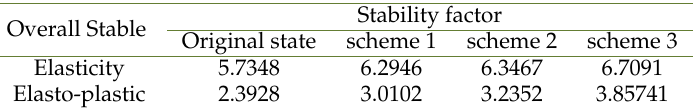
Table 5. The coMParison of global stability factor